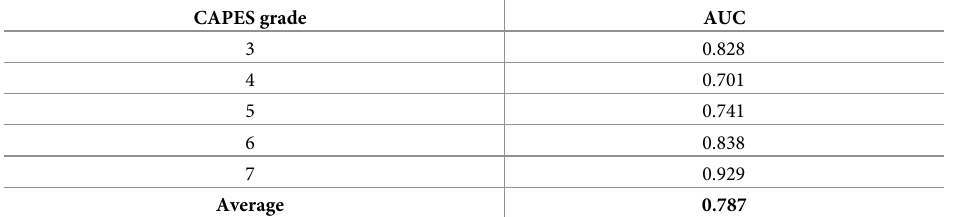
Table 1. Area under the receiver operating characteristic (ROC) curve (AUC) for the Random Forest applied on feature matrix.